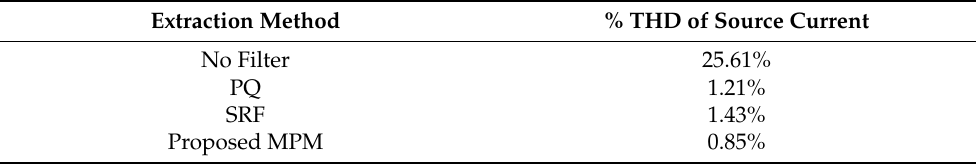
Table 2. Source Current % THD comparison.